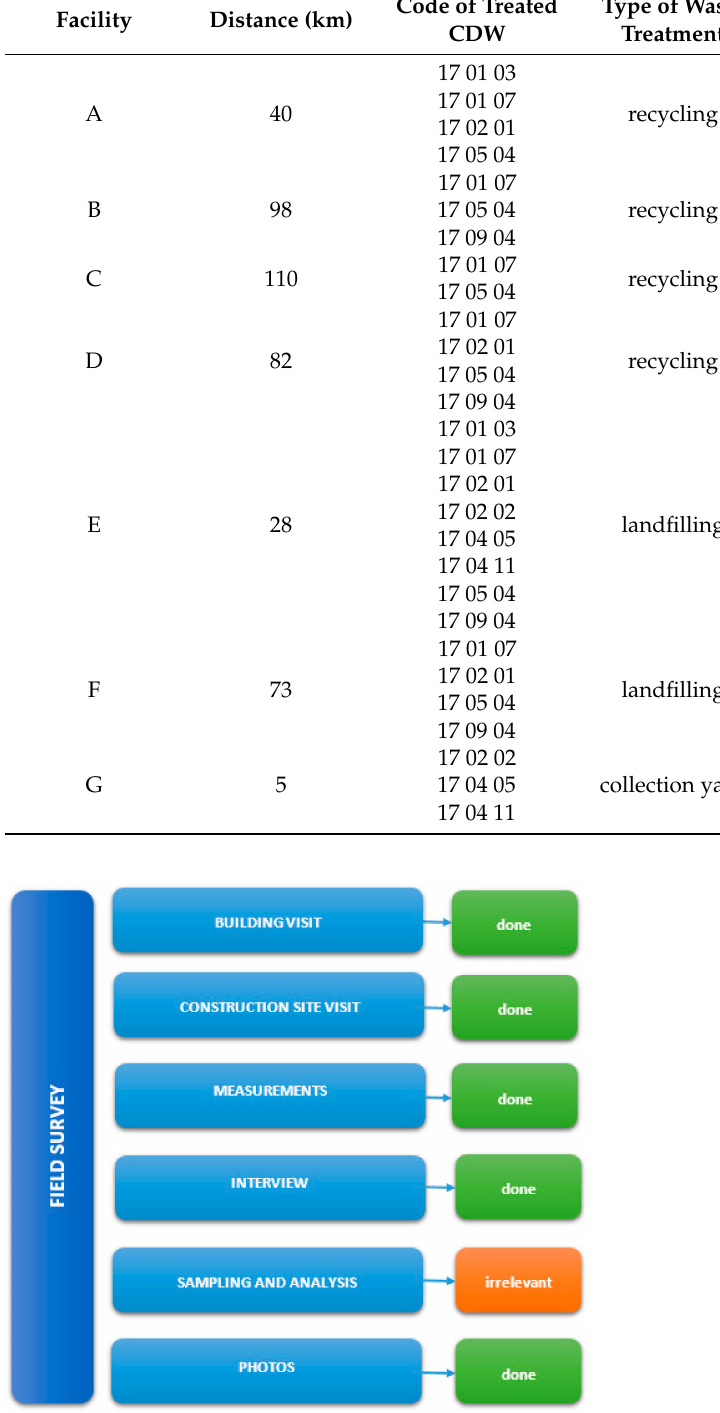
Figure 5. Steps of field survey for construction and demolition waste